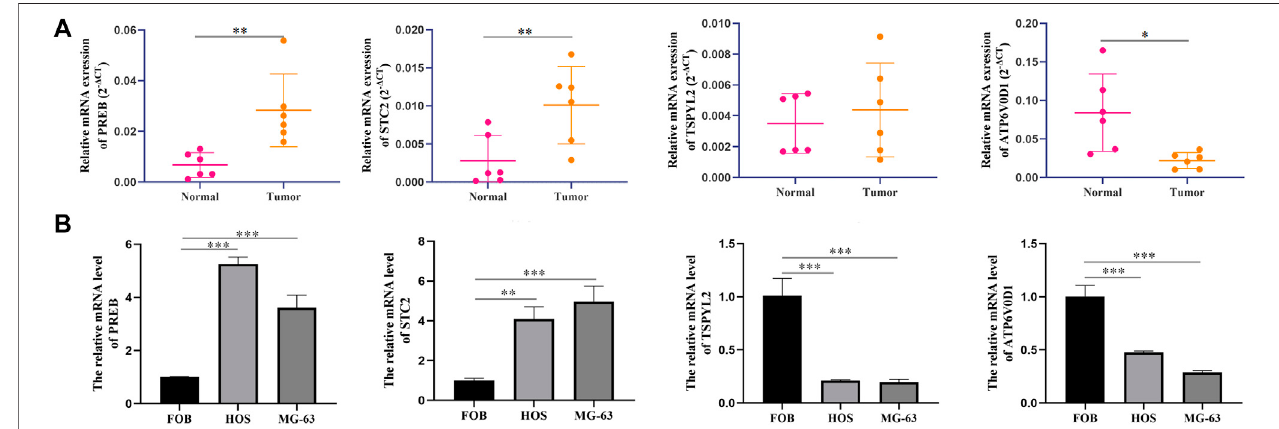
FIGURE8 | Candidate genevalidation. (A) Expression levels ofcandidate genesin tumor and normal tissues from osteosarcoma patients. (B) Expression levels of candidate genes in different cell lines. * p < 0.05; ** p < 0.01; *** p < 0.001.